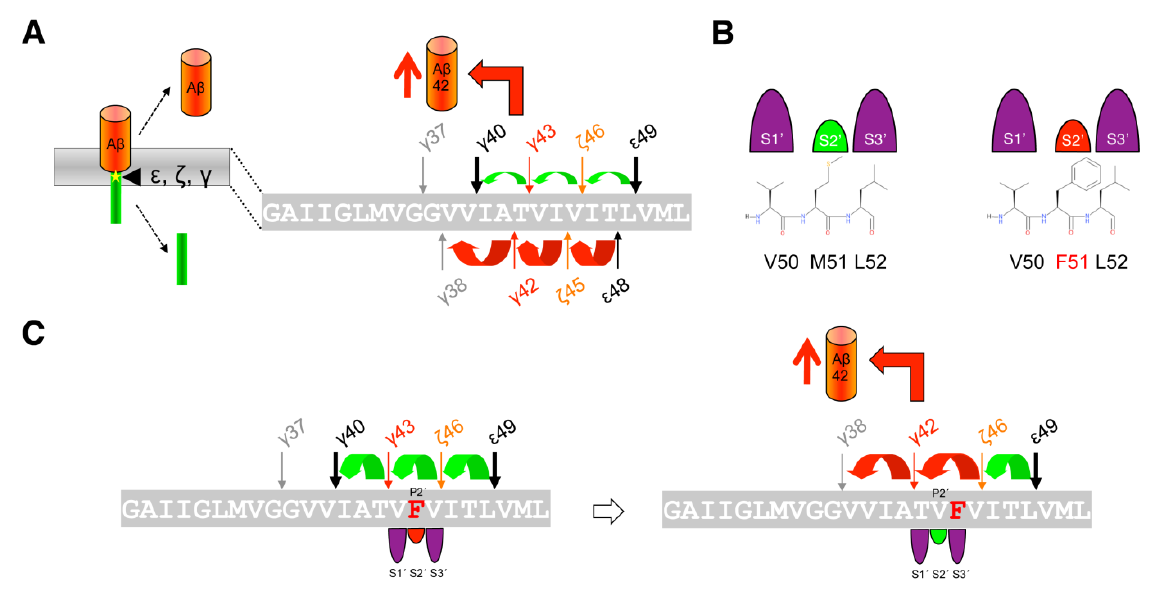
FIGURE 7: Mechanism of APP FAD mutations. (A) Model depicting the shift in the Aβ40 and Aβ42 product lines by APP FAD mutations thereby causing relative increases in the generation of the longer Aβ42 species. Yellow asterisk indicates a FAD mutation. (B) Product line usage is governed by interactions with the S2´ enzyme subsite of γ -secretase. Sterically demanding aromatic amino acids at the P2´ posi- tion of C99 such as in the synthetic M51F mutant clash with the S2´ subsite of the Aβ40 -line. (C) Pathway block by a clash of the aromatic P2´ with the S2 ´ subsite of the Aβ40 -line in the FAD- associated I45F mutant causes a shift to the Aβ42 -product line. Since this mutant does not alter the initial ε - site cleavage, Aβ42 is most likely generated from